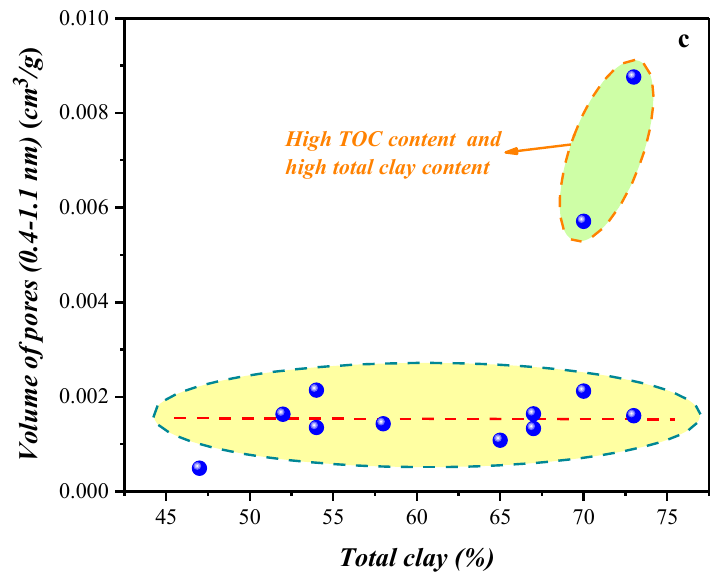
Figure 10. ( a ) Relationship between volume of pores (0.4–1.1 nm) by the low-temperature CO 2 adsorption experiment and TOC content; ( b ) relationship between volume of pores (0.4–1.1 nm) by the low-temperature CO 2 adsorption experiment and quartz content; and ( c ) relationship between volume of pores (0.4–1.1 nm) by the low-temperature CO 2 adsorption experiment and total clay